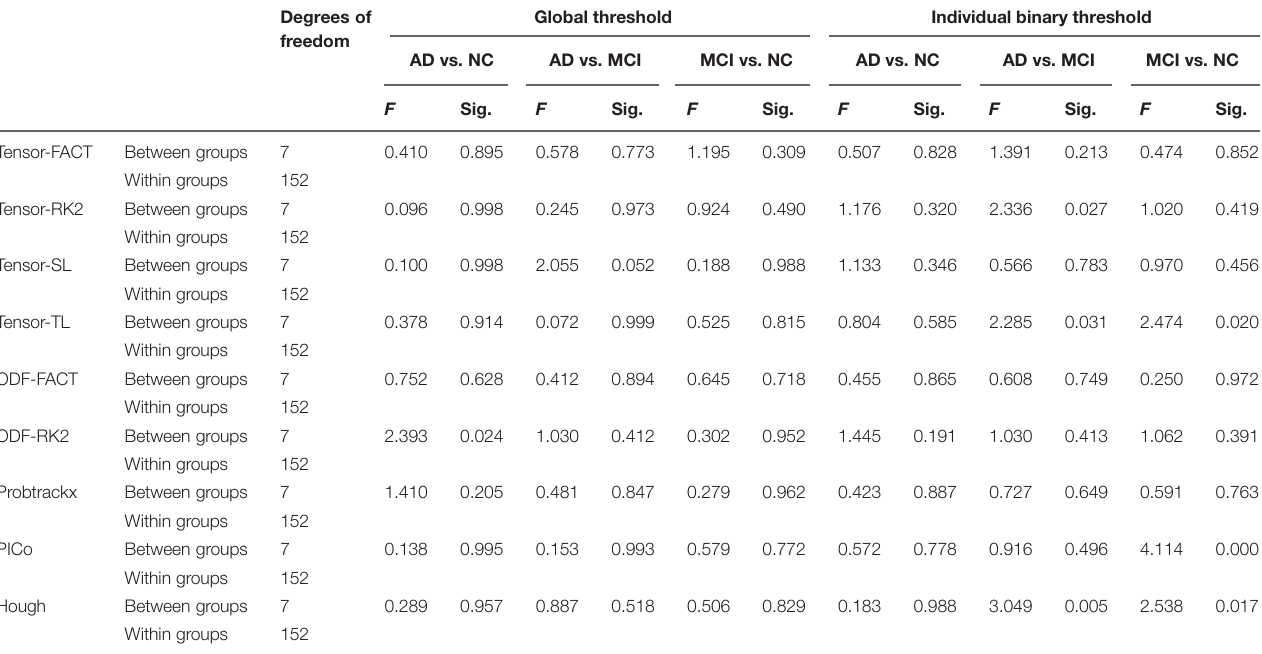
TABLE 4A | One-way ANOVA test on the classification performance across different threshold values for nine tractography algorithms in three diagnostic tasks.